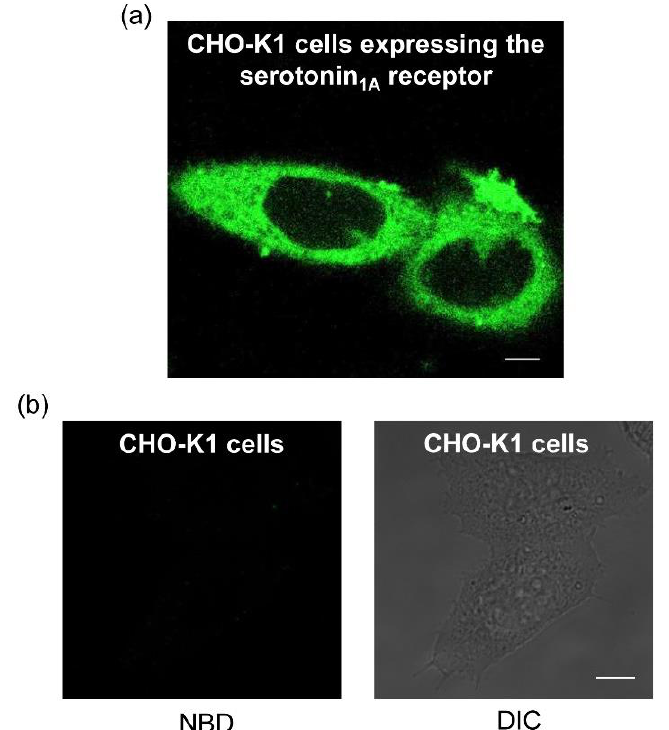
Figure 4. ( a ) Confocal microscopic images obtained by specific labeling of the serotonin 1A receptor stably expressed in CHO-K1 cells with the NBD-labeled analog of serotonin (I). Cells were grown on Lab-Tek chambers and labeled with 7 μM of analog I in HEPES-HANKS buffer, pH 7.2. NBD was excited using a 488 nm argon laser and emission was collected between 505–600 nm. Panel ( b ) shows background fluorescence of untransfected CHO-K1 cells (lacking the serotonin 1A receptor) labeled with 7 μM of analog I under the same conditions as in panel ( a ). The right panel shows DIC image. Scale bars represent 10 μm. See Materials and Methods for other details.